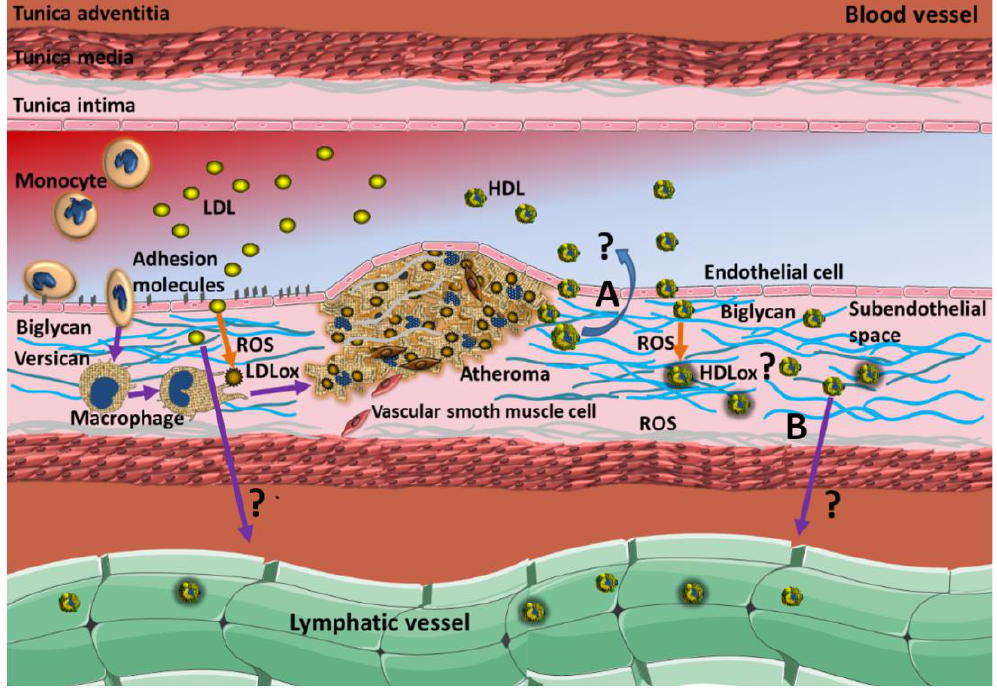
Figure 1. Proposed role of LDL and HDL on atheroma formation and progression. In the onset of endothelial dysfunction, LDLs reach the subendothelial space, where they become oxidized, induce chemiotaxis for monocytes, and are phagocytized by macrophages inducing the inflammatory process and lipid streak formation. By contrast, HDL has been proposed to cross the endothelial barrier and recover the cholesterol from foam cells (cholesterol efflux, not shown in the image). To continue with the next steps of the reverse cholesterol transport, HDL must leave the subendothelial space; for this, the direct return of HDL to blood circulation ( A ) is not physicochemically favored against hydraulic pressure and concentration gradient. The lymphatic circulation is the most plausible alternative for HDL to abandon the blood vessel ( B ), but this way out is also accessible for LDL. LDL seems to be retained in the tissue by interacting with versican and biglycan, which also interacts and probably retains HDL in the subendothelial space, impeding the next steps of RCT.